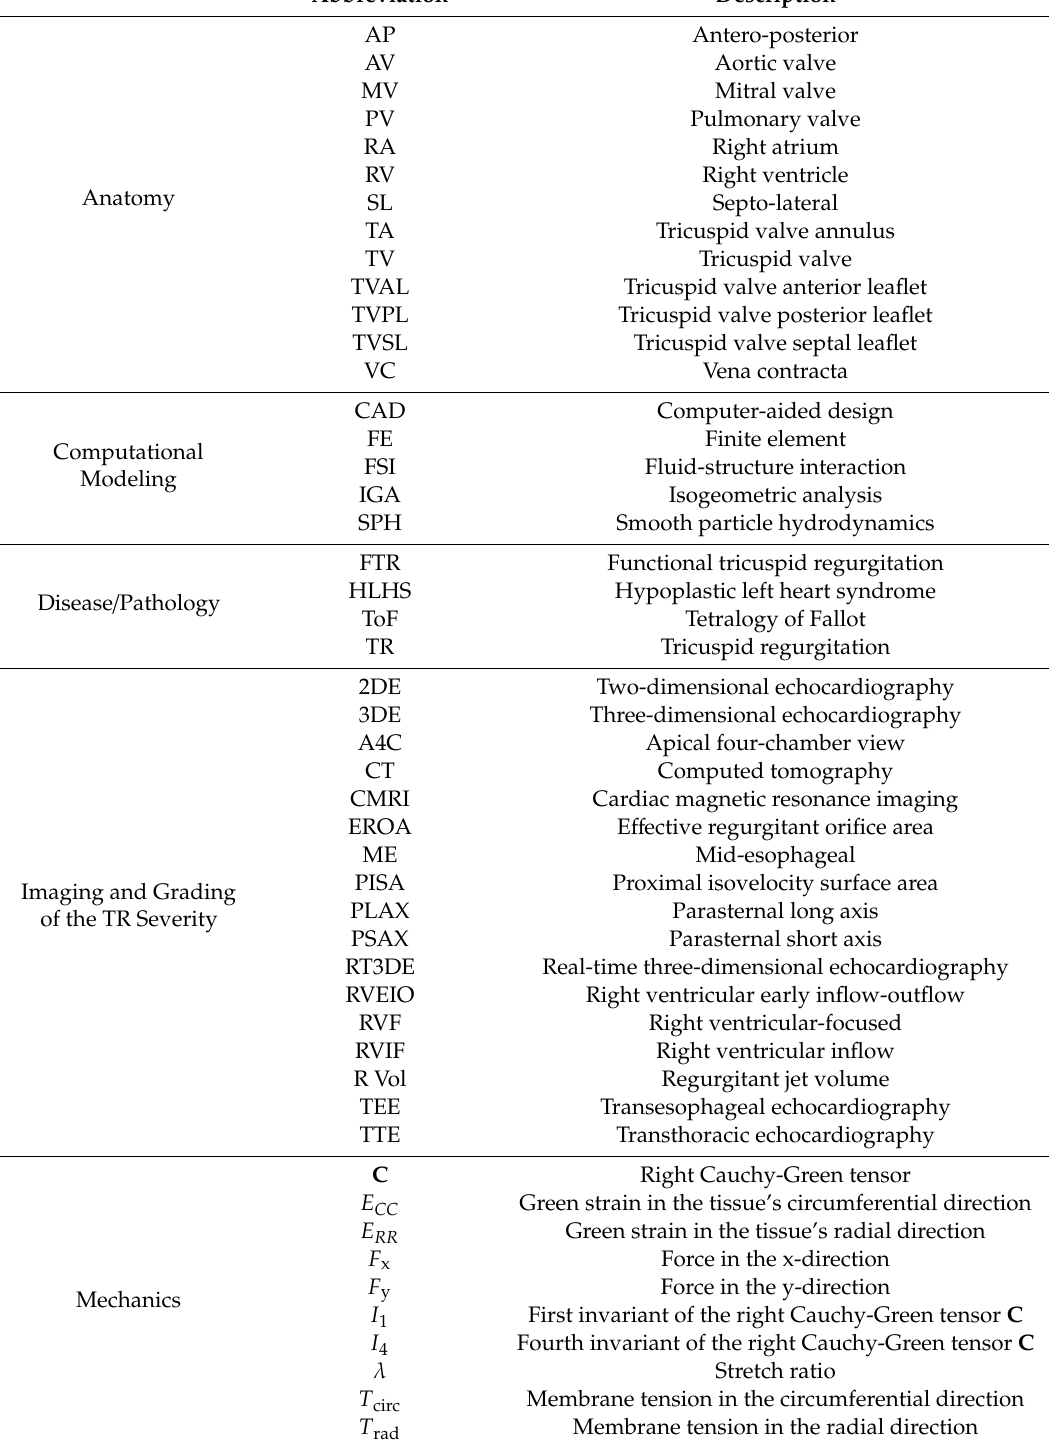
Table 1. Nomenclature for all the abbreviations adopted in this review